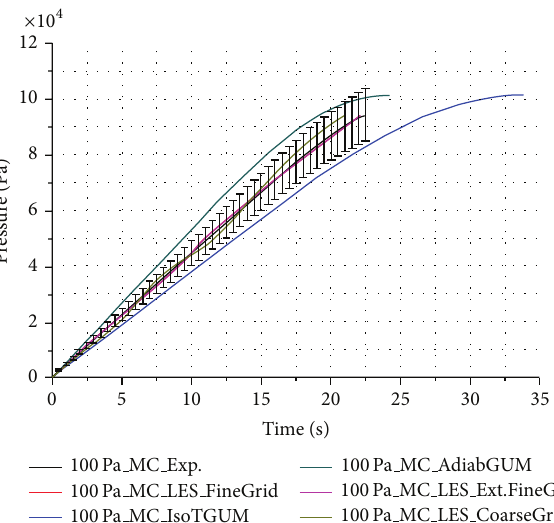
Figure 27: Simulation velocity trend at different pressurization rates.